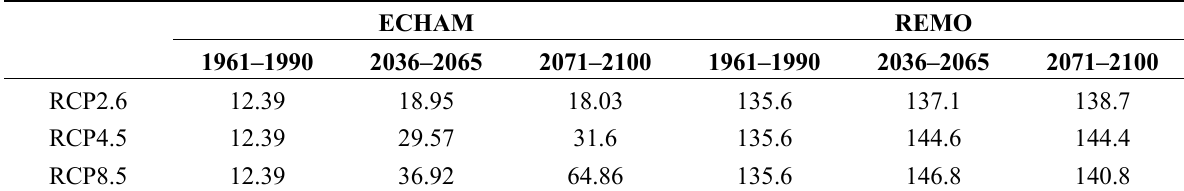
Table 1. Number of extreme rainfall events for MPI-ESM and REMO for